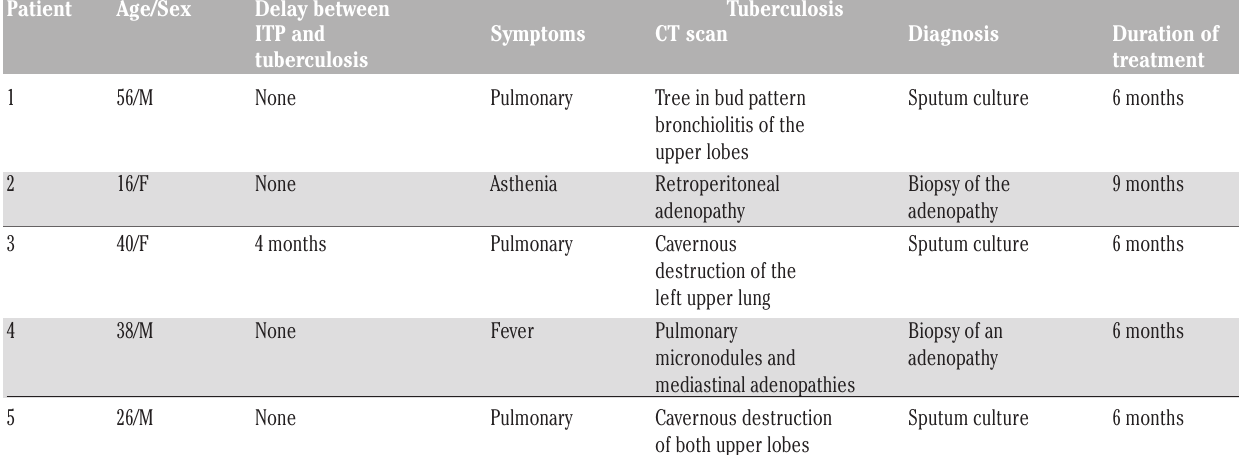
Table 1. Characteristics of the 5 patients with immune thrombocytopenic purpura and tuberculosis.